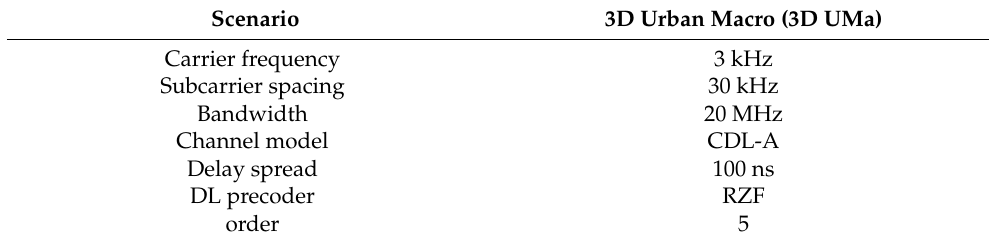
Table 2. Some common sparseness criteria.